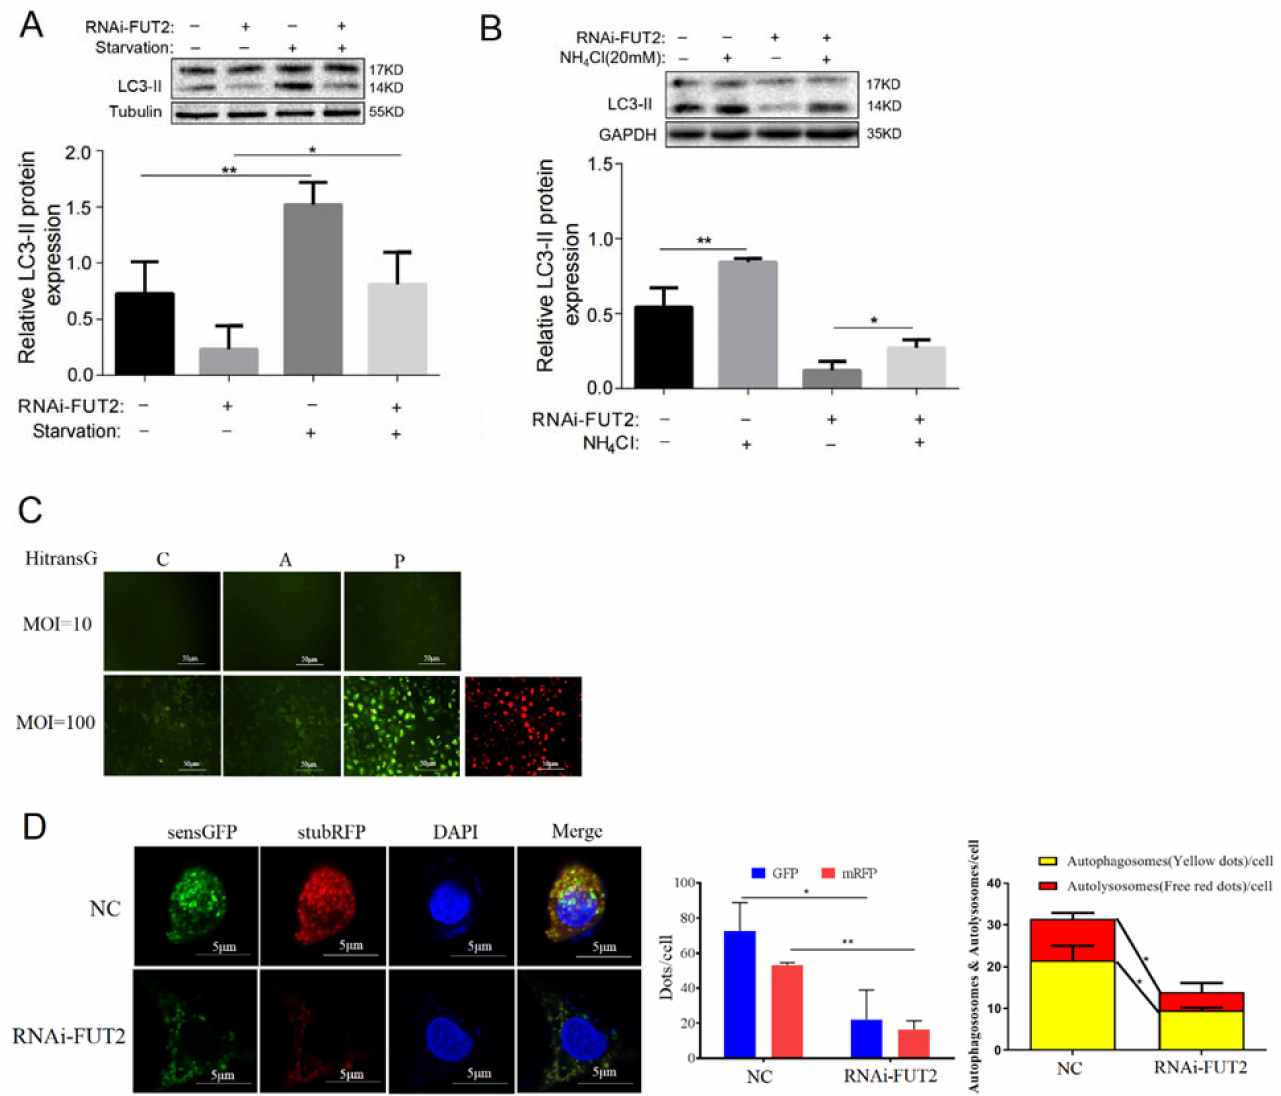
Figure 3. FUT2 boosts the early stage of autophagy in lung adenocarcinoma cells. ( A ) Representa- tive Western blot showing that knockdown of FUT2 reduced the expression of LC3-II induced by serum starvation in A549 cells. ( B ) Representative Western blot showing that the knockdown of FUT2 reduced the expression of LC3-II induced by NH 4 Cl in A549 cells. ( C ) Representative image of immunofluorescence staining showing the stubRFP-sensGFP-LC3 double-fluorescence system. ( D ) Representative image of immunofluorescence staining showing that the knockdown of FUT2 decreased both autophagosomes (yellow dots) and autolysosomes (free red dots). (* p < 0.05, and ** p <